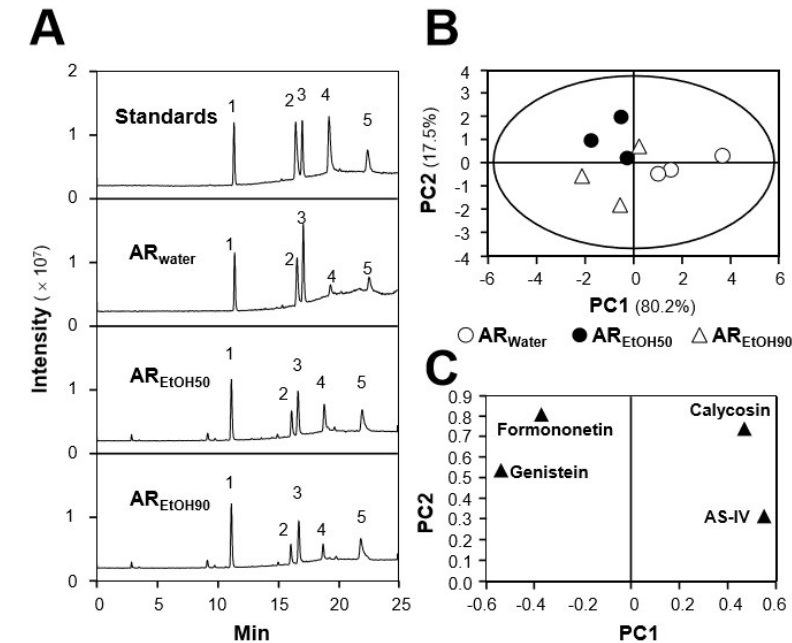
Figure 1. Principal component analysis (PCA) of major compunds in different Astragali Radix (AR) extracts. ( A ) The identification of ginsenoside Rg1 (1; internal control marker), calycosin (2), astragaloside IV (3), genistein (4), and formononetin (5) was made by an MS detector. Representative chromatograms of chemical markers (Standards), water extract of AR (AR water ), 50% ethanol extract of AR (AR EtOH50 ), and 90% ethanol extract of AR (AR EtOH90 ) under MRM mode are shown. ( B ) The scoring plot of different AR extracts is presented by comparing the contents of chosen major compounds. PC1 and PC2 described ~80.2% and ~17.5% of total variability, respectively. ( C ) The loading plot of PC1 versus PC2 for four compounds is shown. n = 3. Table 1. Quantitative assessment of four chemical standards in different AR extracts. Standards